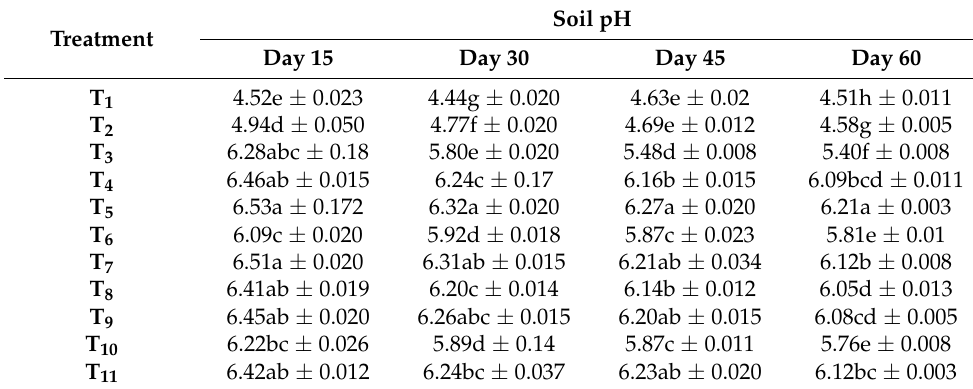
Table 4. Effect of RHB, EFBB, and dolomitic limestone treatments on soil pH.